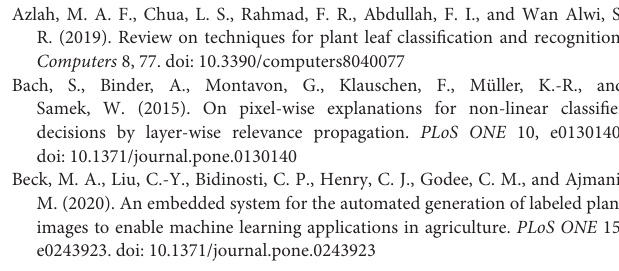
Epoch (best) Epoch (1) Training Testing Training Testing dataset (%) dataset (%) dataset (%) dataset